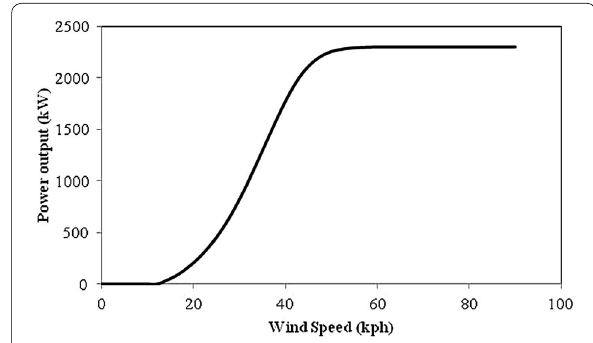
Fig. 4 Power curve of Siemens SWT–2.3 82 wind turbine (Staffell